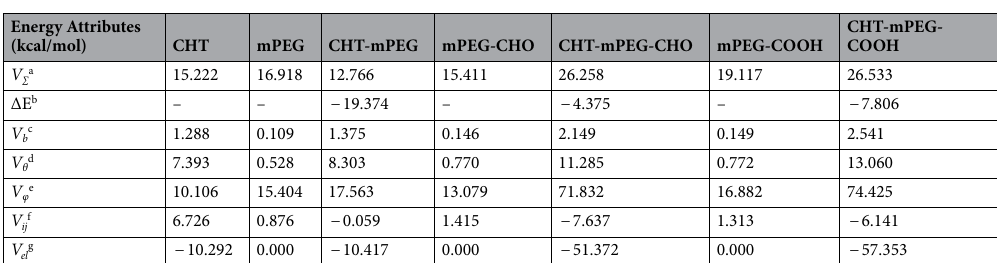
Table 6. Computational energy attributes calculated for the simulated CHT-mPEG blend system in a molecular mechanics’ force field setup. a Minimized global energy for an optimized structure; b ΔE c bond stretching contributions; d bond angle contributions; interaction = E(Host.Guest) − E(Host) − E(Guest); e torsional contribution arising from deviations from optimum dihedral angles; f van der Waals interactions; g electrostatic